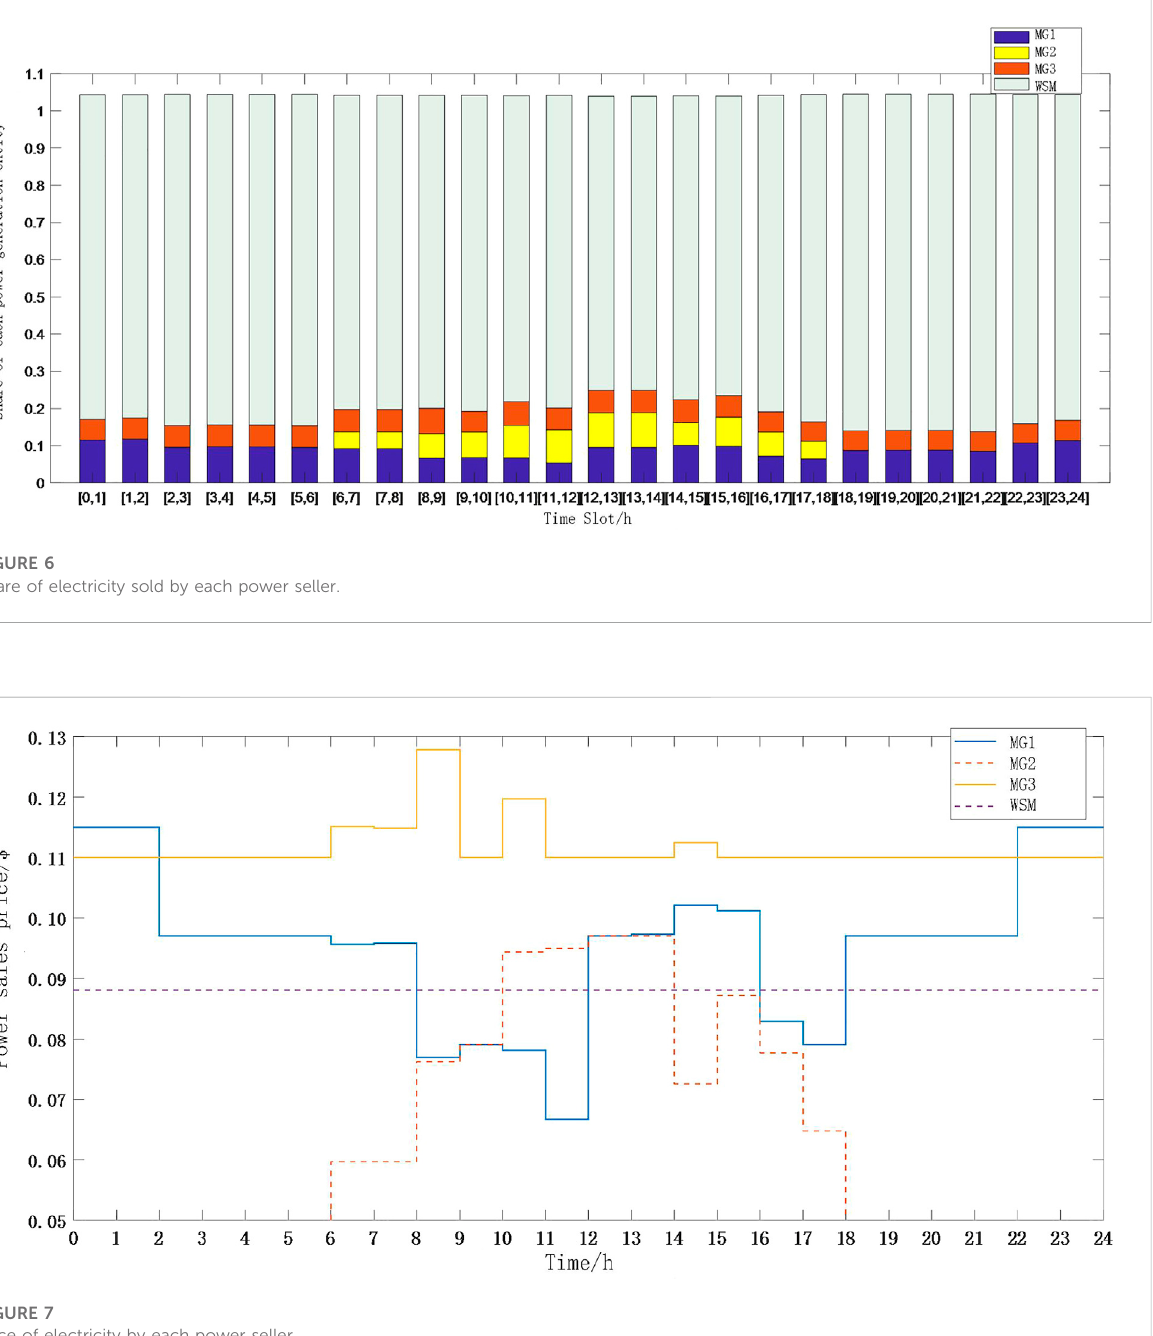
FIGURE 7 Price of electricity by each power